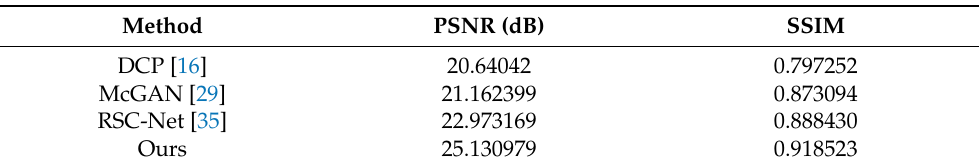
Table 7. Average PSNR and SSIM values of images reconstructed with various methods using the RICE1 test set.